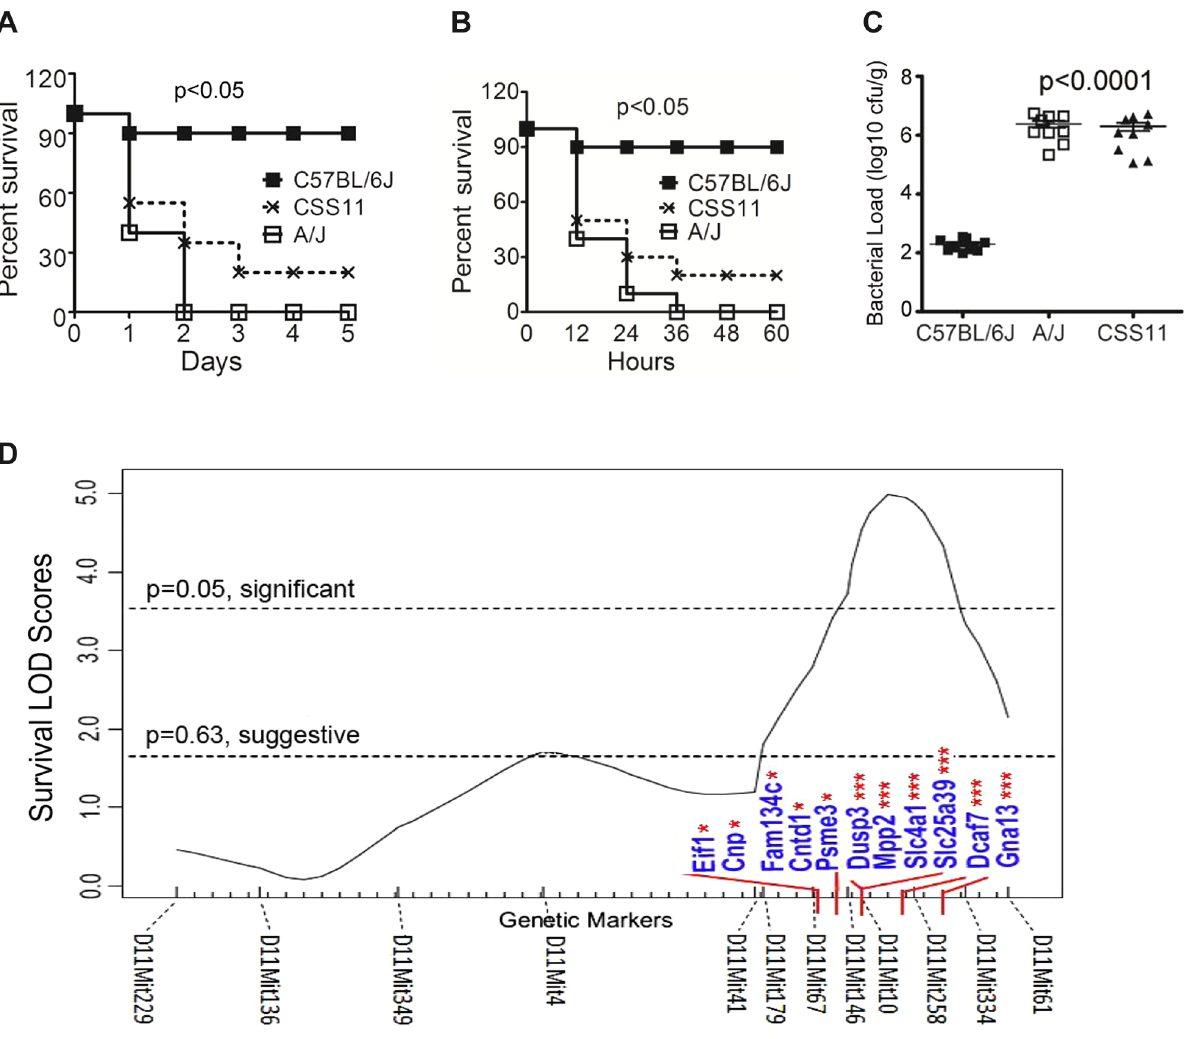
Figure 1. Chromosome substitution strain 11 was susceptible to S.aureus infection, and QTL mapping found eleven putative candidate genes on Chr11. ( A ) CSS11 was susceptible to S. aureus peritoneal sepsis. C57BL/6J, A/J, or CSS11 mice were injected (i.p.) with S. aureus Sanger 476 at 10 7 CFU/g (n=10 for each strain). Comparison of survival curves was performed by Mann-Whitney u test. The difference between C57BL/6J and CSS11 mice was significant (p , 0.05). (B) CSS11 was susceptible to S. aureus intravenous sepsis. C57BL/6J, A/J, or CSS11 were intravenous injected with S. aureus Sanger 476 at 2 6 10 6 CFU/g (n=10 for each strain). Comparison of survival curves was performed by Mann- Whitney u test. The difference between C57BL/6J and CSS11 mice was significant (p , 0.05). ( C ) Bacterial load in kidneys were significantly higher in CSS11 mice after S. aureus injection. C57BL/6J, A/J and CSS11 were injected (i.p.) with S. aureus Sanger 476 at 10 7 CFU/g and euthanized 24 hours post infection (n=10 for each group). The bacterial load in CSS11 kidneys were significantly higher than C57BL/6J (2.0 6 1.32 6 10 6 CFU/ml vs 200 6 158 CFU/ml, p , 0.0001). ( D ) Chromosome 11 LOD score plot for susceptibility to S. aureus in F2 intercross mice (F1 [C11A] 6 F1 [C11A]). Six to eight-week-old intercross mice were injected i.p. with 10 7 CFU/g S. aureus Sanger 476 and observed every 8 hours continuously for 5 days. Thresholds for significant (p=0.05) and suggestive (p=0.63) linkage are indicated by the horizontal dashed lines. LOD score was determined by the J/ qtl permutation test using 1,000 permuted data sets. The microsatellite markers for determining genotypes of F2 intercross mice are marked along the X-axis. The differentially expressed genes are indicated. Genes identified within significant or suggestive QTL were indicated with *** or *, respectively. Footnote: Figure 1A and 1C have been presented in Ahn S, et al., 2010 PLoS Pathogens ,